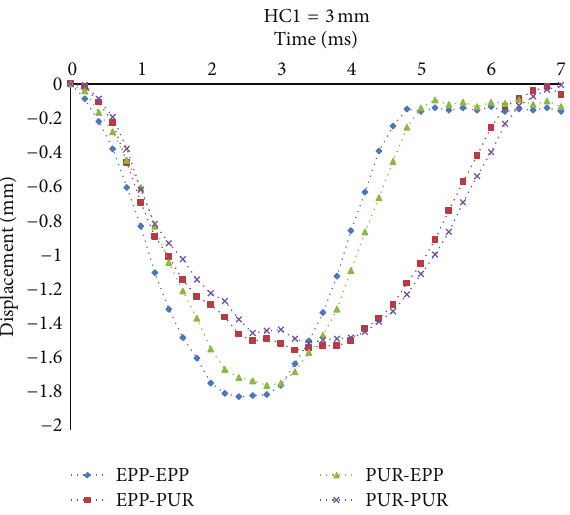
Figure 9: Deflection of target with HC1 = 3 mm in four